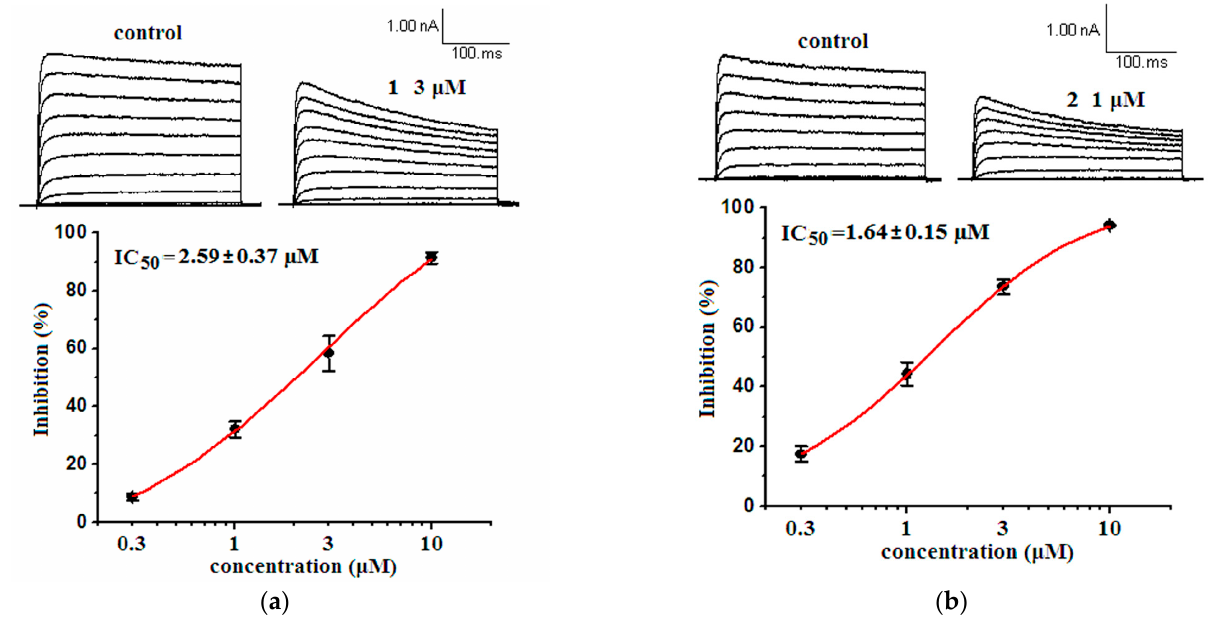
Figure 6. Kv1.5 currents and concentration–inhibition curve in the absence and presence of 0.3 µM, 1 µM, 3 µM and 10 µM compounds. The abscissa represents the concentration, and the ordinate represents the percentage of Kv1.5 current that is blocked at different concentrations of compounds. Data points represent mean ± SEM of 4 measurements. ( a ) The inhibitory effect of 1 showed an IC 50 value of 2.59 ± 0.37 µM. ( b ) The inhibitory e ff ect of 2 showed an IC 50 value of 1.64 ± 0.15 µM.